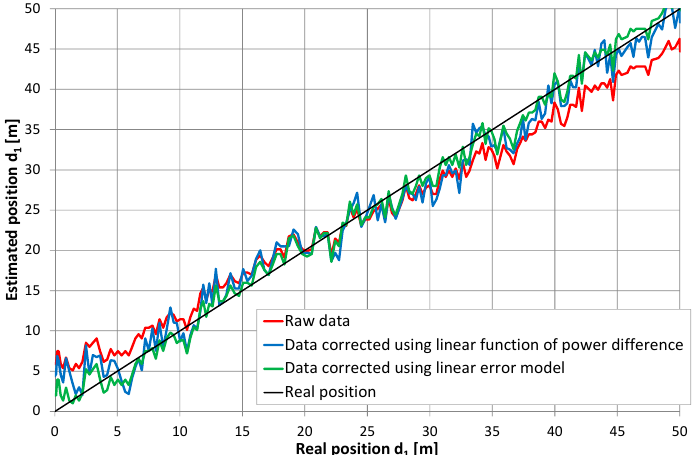
Figure 18. Results of position estimation in series 12 with correction based on the difference in direct and return signal power levels and corrections based on the linear model’s position errors.